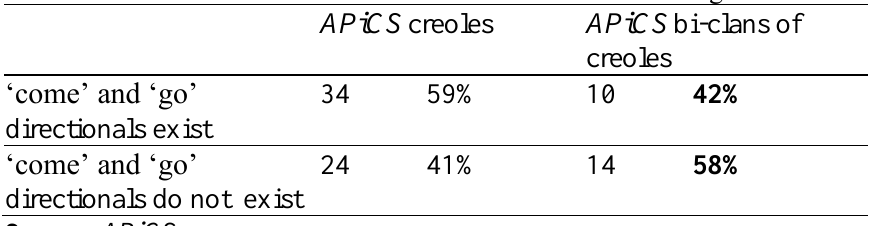
Table 3. Directional serial verb constructions with ‘come’ and